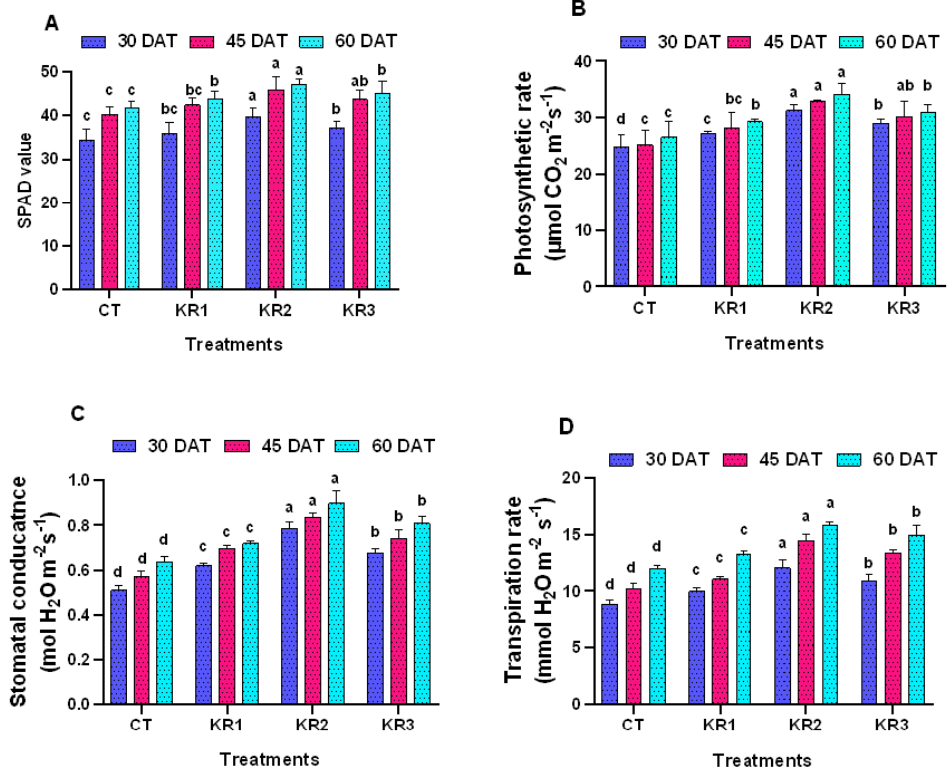
Figure 3. Physiological parameters of tomato plants treated with Kendal Root biostimulant: ( A ) SPAD value; ( B ) photosynthetic rate; ( C ) stomatal conductance; and ( D ) transpiration rate. Data in the figure are expressed as mean ± SE. Mean values followed by the same letter do not differ significantly at p ≤ 0.05 by DMRT.